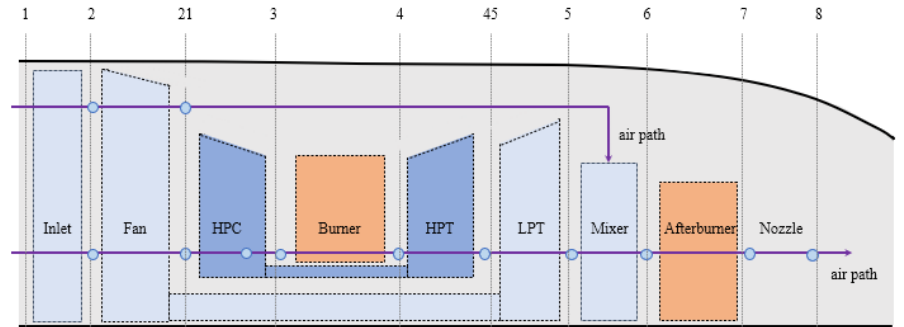
Figure 3. Schematic diagram of two-spool mixed flow turbofan engine.